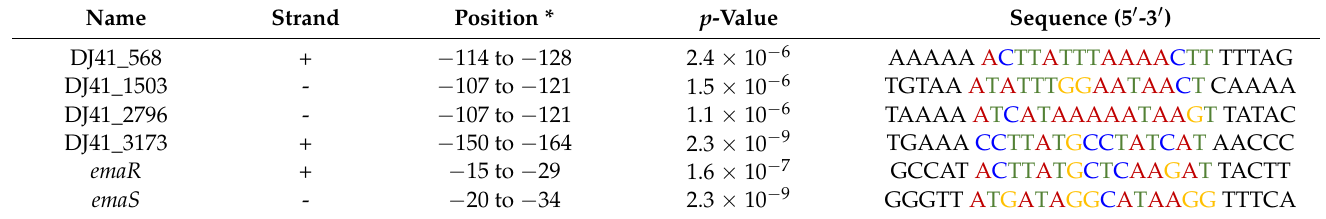
Table 2. EmaR binding boxes on EmaSR-regulated genes.